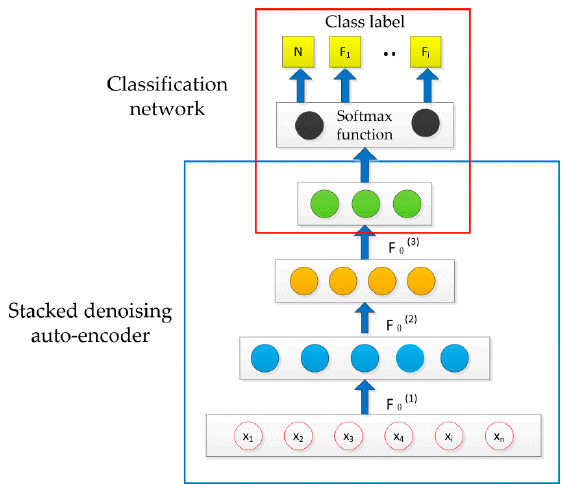
Figure 4. Deep neural network (DNN) framework.